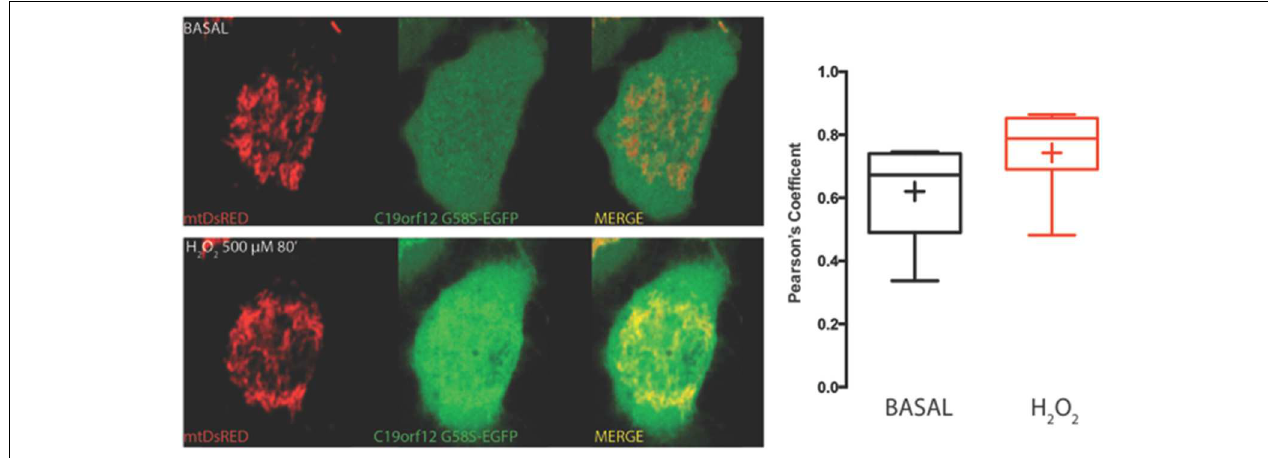
FIGURE 4 | Redistribution of C19orf12 G58S mutant during oxidative stress. Representative HeLa cells overexpressing the C19orf12 G58S-EGFP fusion protein and the mitochondrial marker mtDsRED before (upper panel) and after (lower panel) exposure to